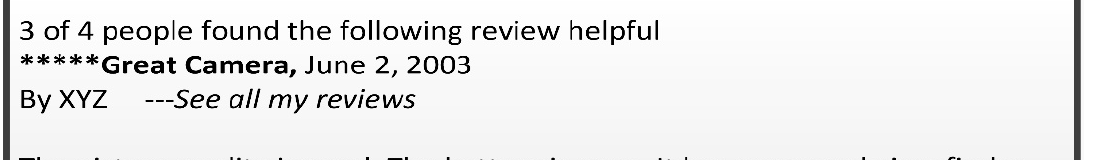
Figure 1. Hierarchy of the review tuple .